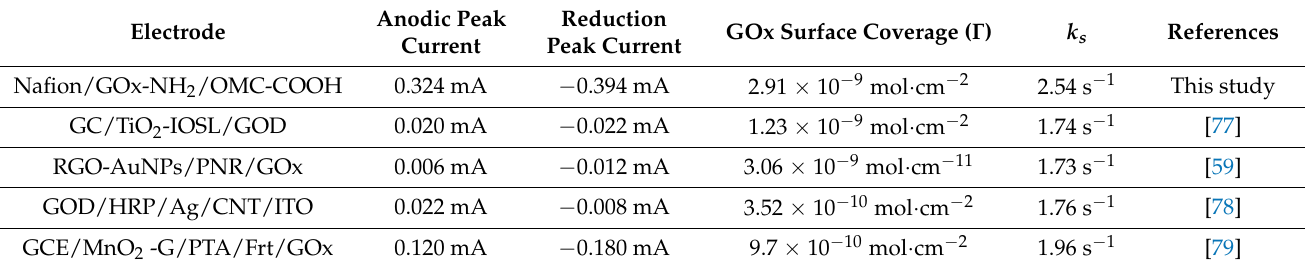
Table 2. Comparison between various GOx